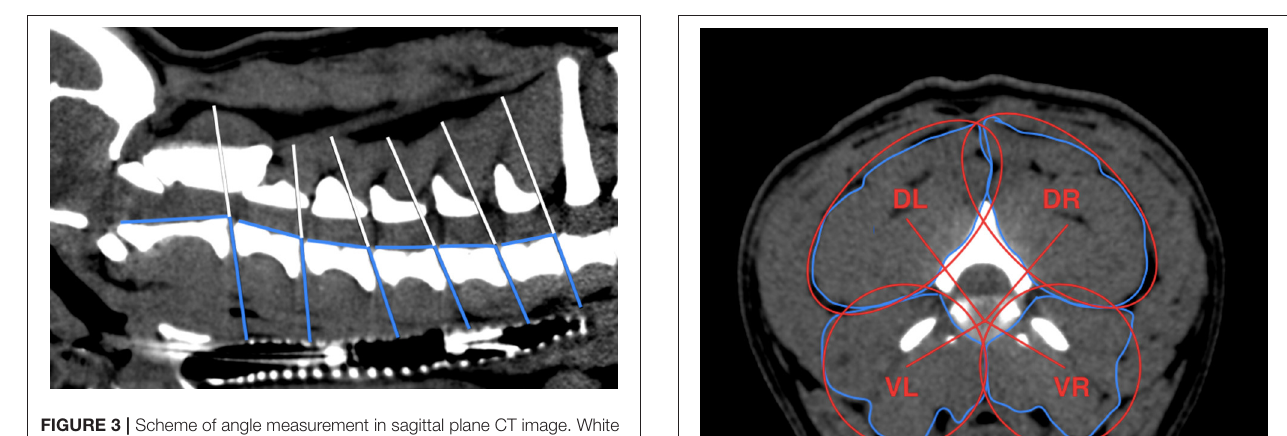
and right areas leading to a ventral right (vr) and a ventral left (vl) muscle area, which were added up to the ventral paraspinal musculature (vrl). Dorsal right (dr) and dorsal left (dl) muscle areas were added up to the dorsal paraspinal musculature